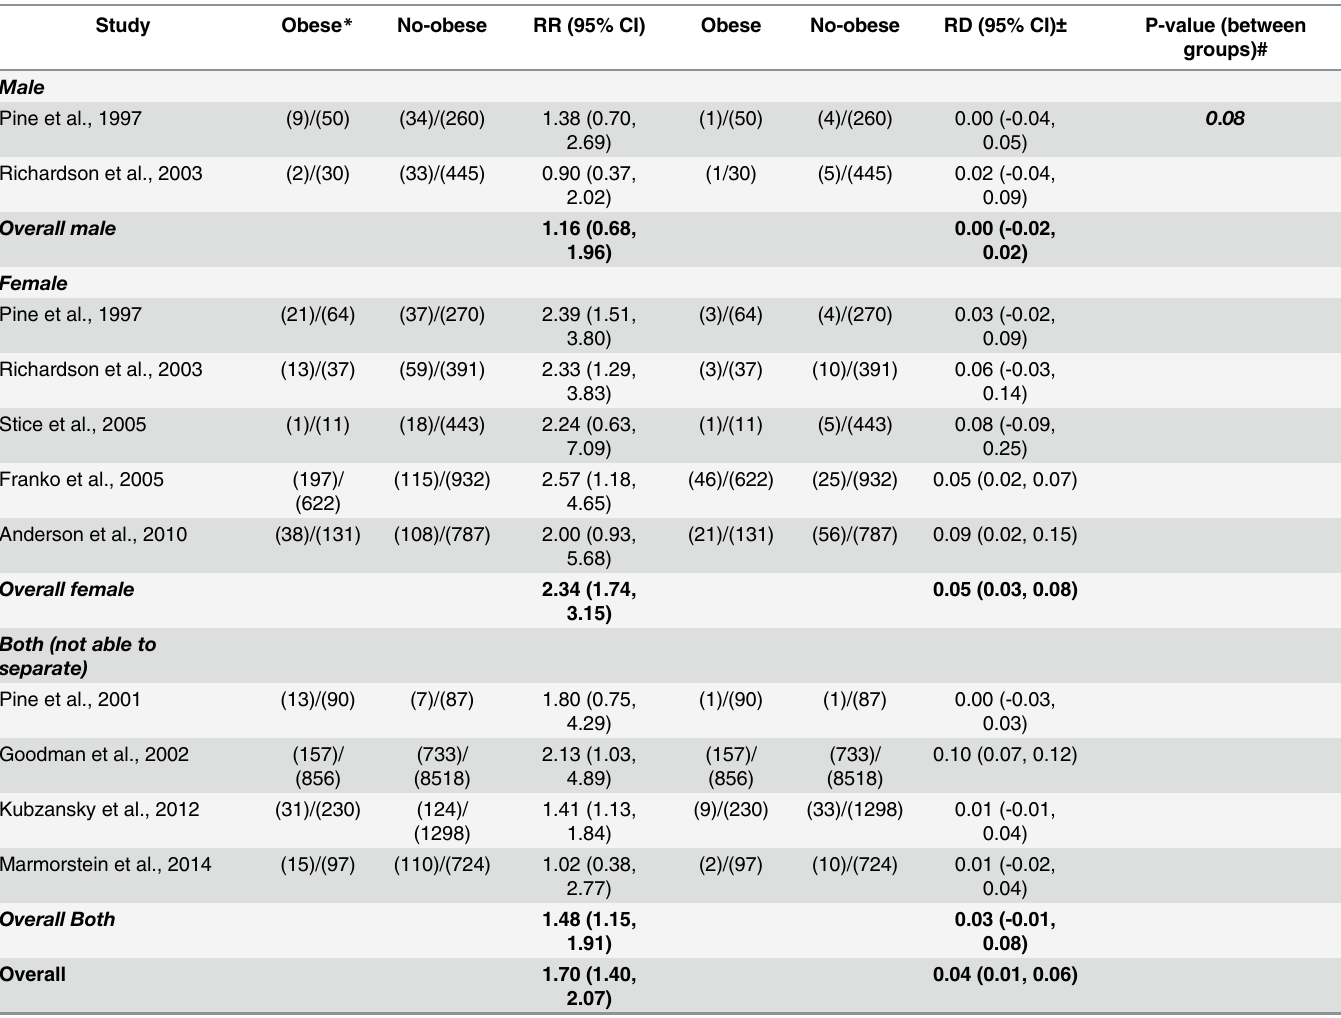
Table 2. Pooled estimates of incidence depression leading to obesity measured in terms of relative and absolute risk using quality effect